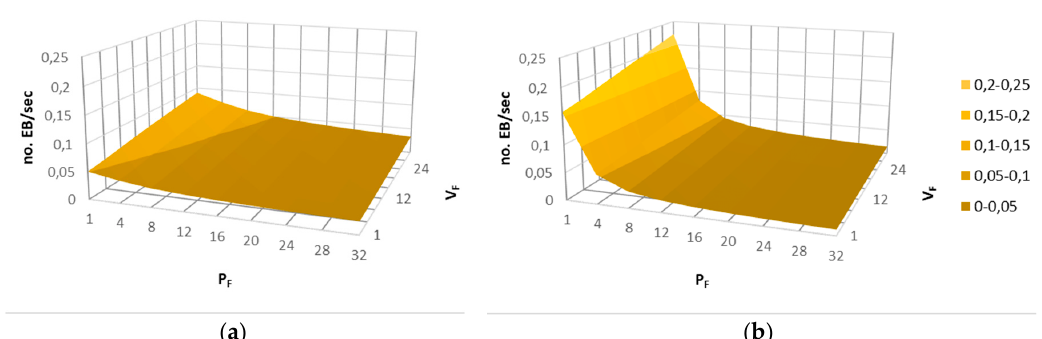
Figure 16. Number of beacons per second for different Bell-X configurations; (a) Fixed parameters SF = 4, Imin = 4, D = 4; (b) Fixed parameters S F = 4, I min = 1, D = 8.